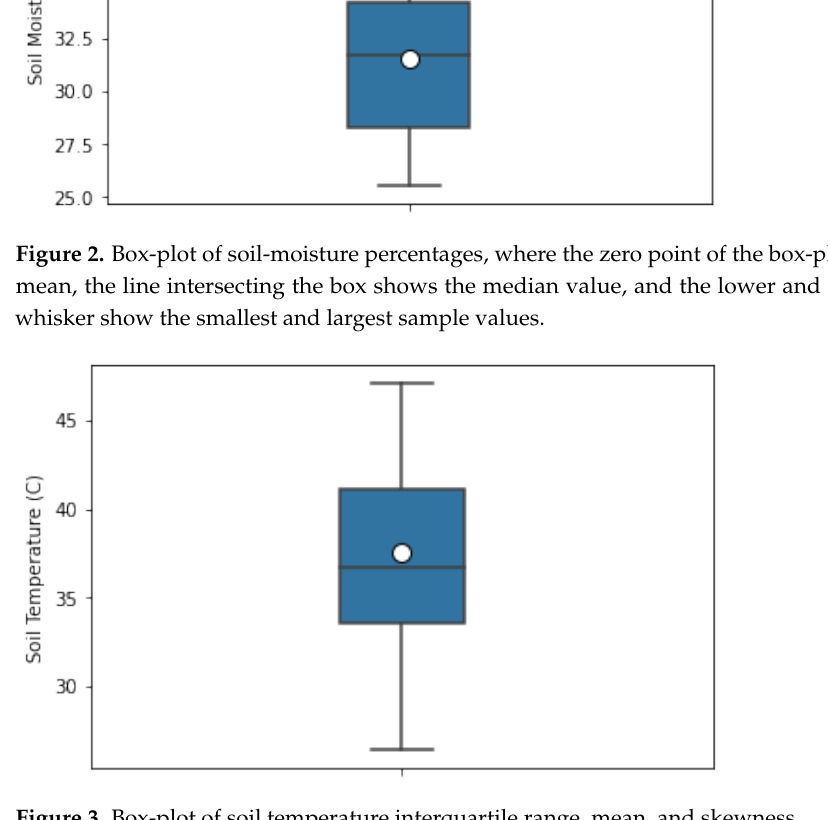
Figure 3. Box-plot of soil temperature interquartile range, mean, and